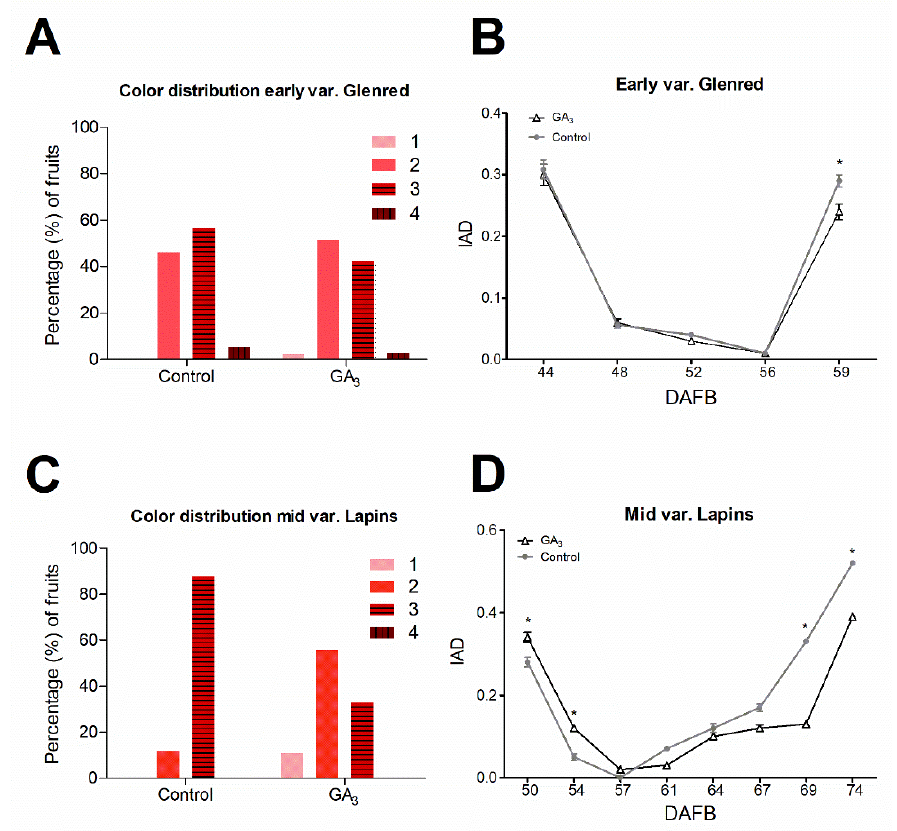
Figure 3. E ff ect of GA 3 on color distribution and index of absorbance di ff erence (IAD) at harvest of early-season variety, Glenred ( A , B ) and mid-season variety, Lapins ( C , D ). 20 fruits from control and GA 3 trees of Lapins and Glenred were randomly selected for nondestructive IAD measurements in the field and 25 fruits for color distribution assessment at harvest. Data as ± SEM ANOVA with Tukey’s post hoc test at p < 0.05 was conducted; “*” denotes statistical di ff erences between GA 3 -treated and control fruits CTIFL (Centre Technique Interprofessionnel des Fruits et L é gumes) color chart was used in ( B , D ), where 1 is the lightest color, and 4 is the darkest color, respectively (Figure S3). DAFB, days after full bloom.